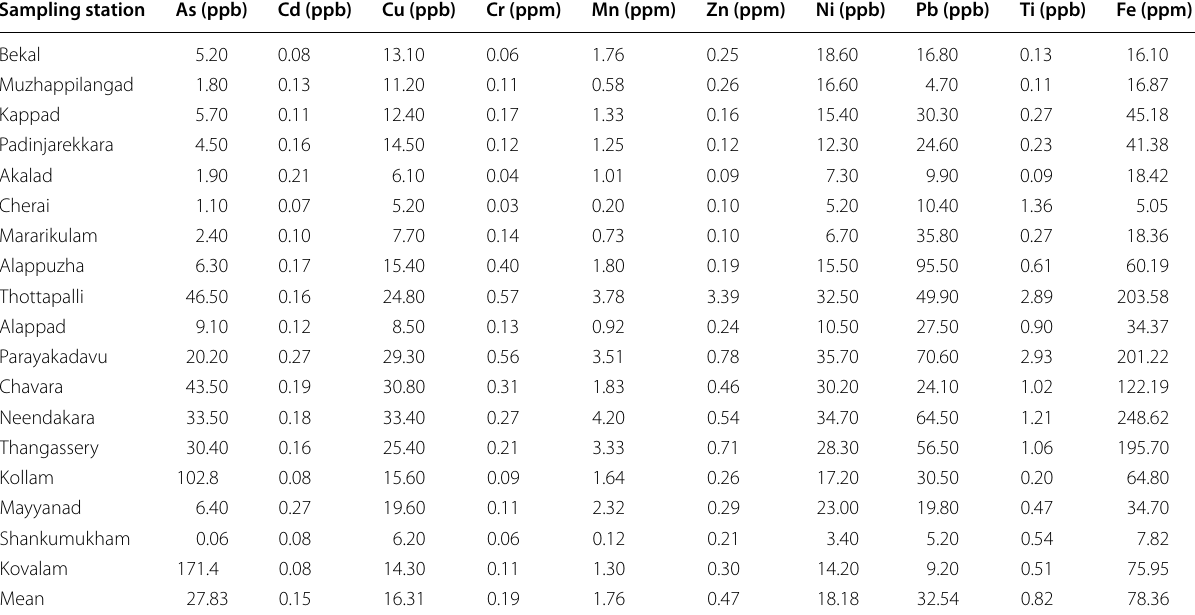
Table 8 Concentration of trace elements in the sediment samples collected from the coastal belt of Kerala Sampling